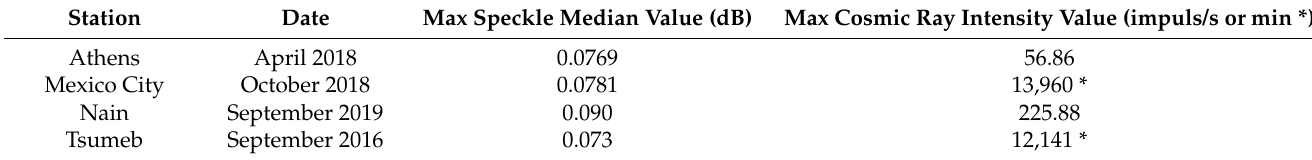
Table 5. The maximum values of both datasets which were seen on the same date.